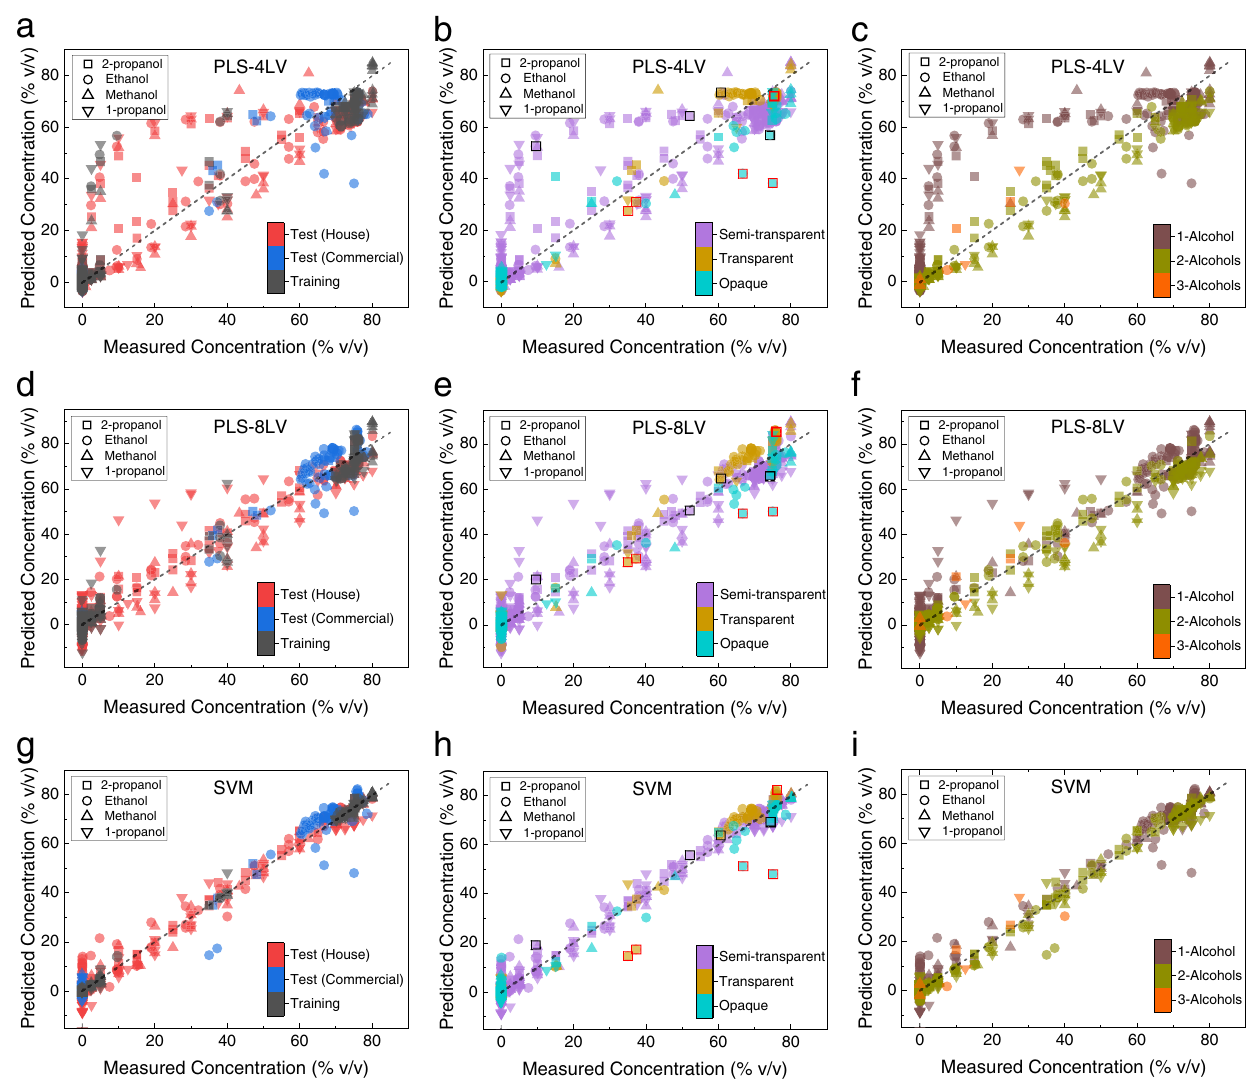
Fig. 4 Quanti fi cation of alcohol amounts in hand sanitizers. Predicted alcohol concentrations plotted against measured values for a – c PLS-4, d – f PLS-8, and g – i SVM models. Each symbol represents a separate alcohol, products are color-coded based on origin ( a , d , g ), container type ( b , e , h ), and the number of alcohols ( c , f , i ). Outliers with large prediction errors and well-predicted samples with small prediction errors are surrounded in red and black squares, respectively, and spectra are compared (Supplementary Fig.